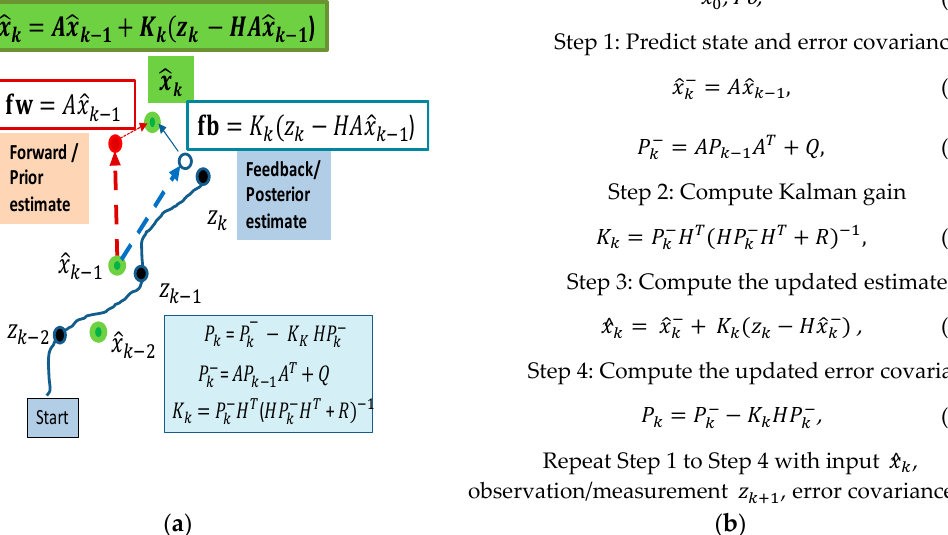
Figure 2. ( a ) An illustration of the Kalman filter algorithm and ( b ) a computational procedure based on [31]. In each time step, the algorithm estimates state ˆ x k by combining forward (prior) estimate = A ˆ x ) and feedback (posterior) estimate ( K ( ˆ x − k − 1 k K